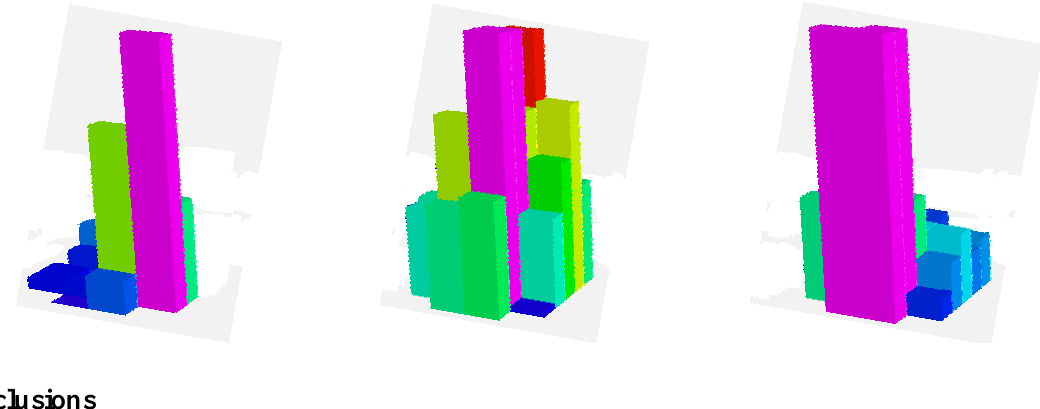
Figure 10. Distribution of the pressure measurements registered by the arrays of tactile sensors of the three fingers in an intermediate iteration during the manipulation task (second